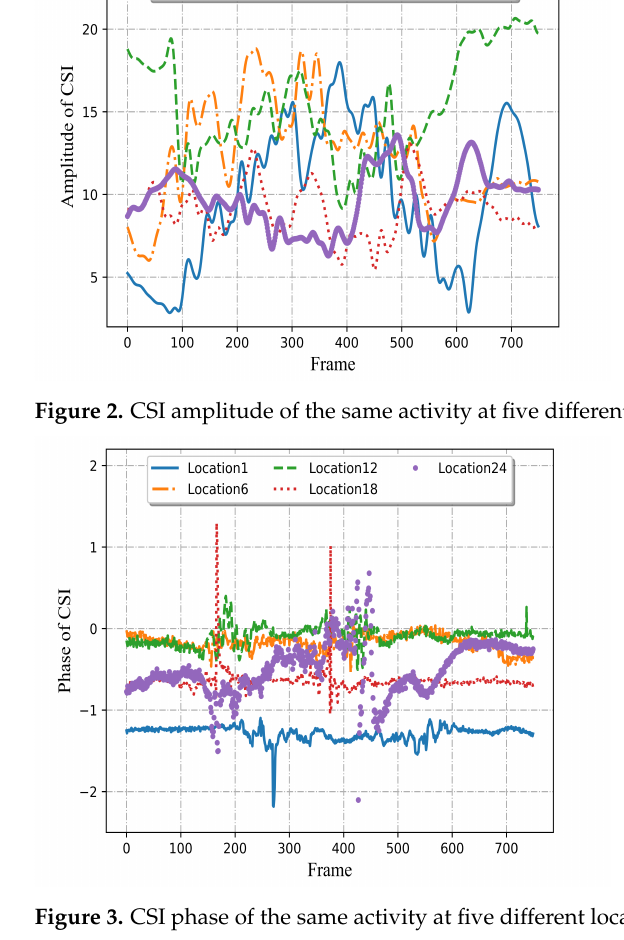
Figure 3. CSI phase of the same activity at five different